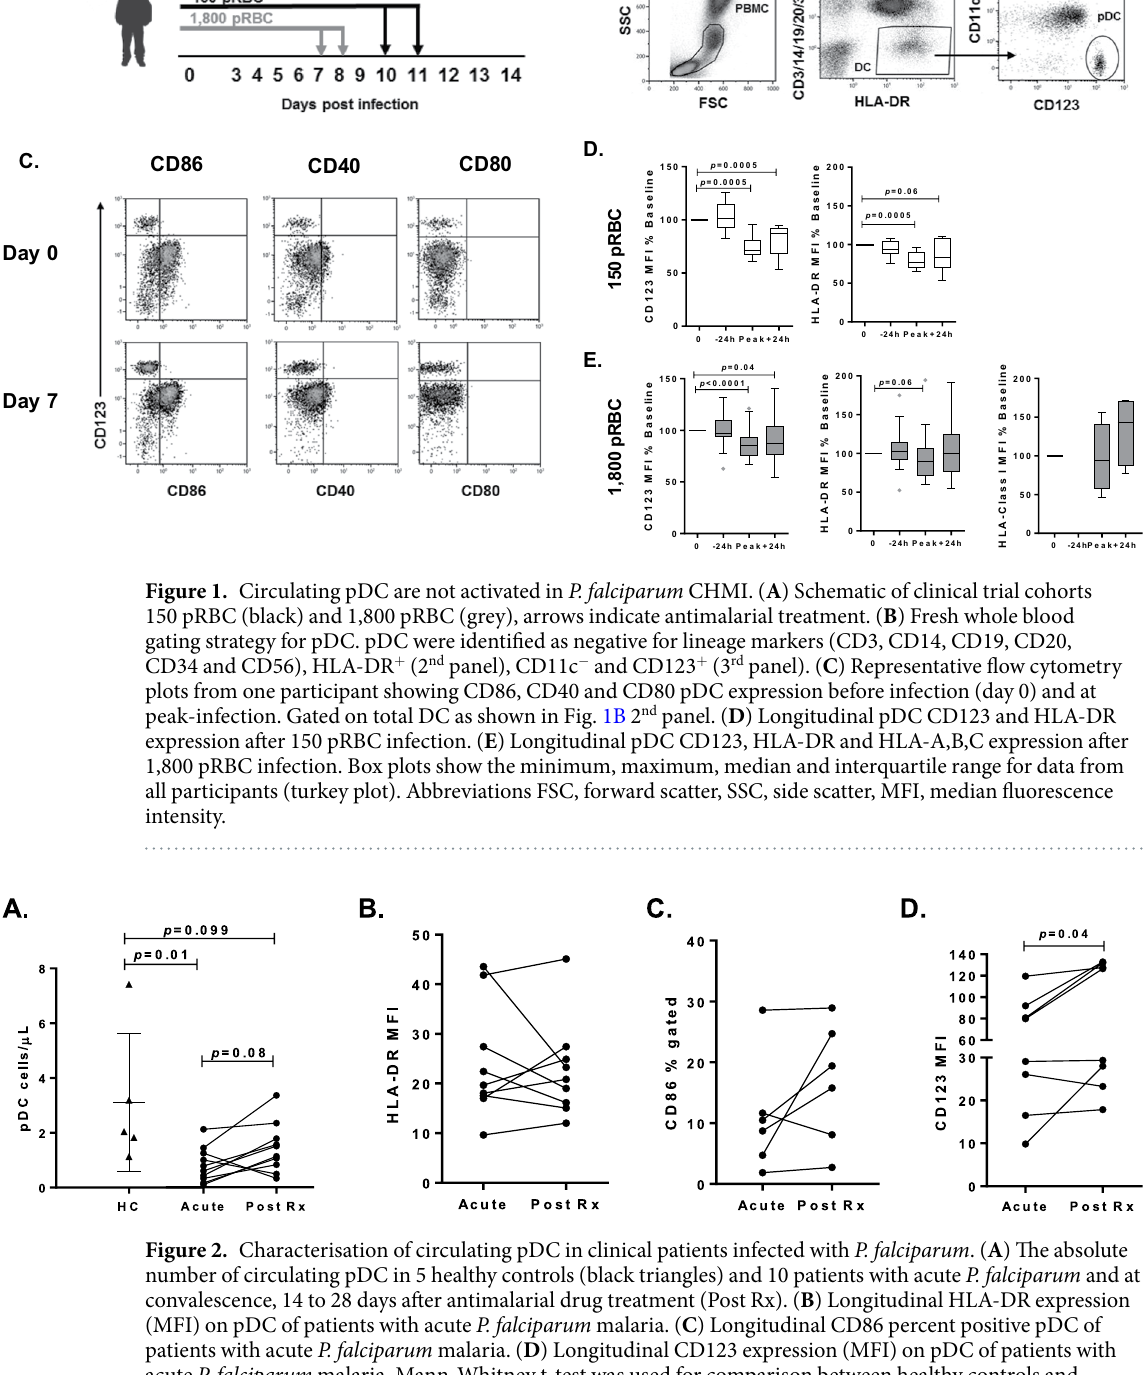
expression before and at the peak of a primary P. falciparum CHMI. Unexpectedly, we found pDC gene expres- sion to be largely stable in early sub-microscope infection. The observed minimal change in gene expression, together with an absence of activation/maturation phenotype by flow cytometry suggests, circulating blood pDC are not activated, yet remain functional during pre-patent blood-stage infection.